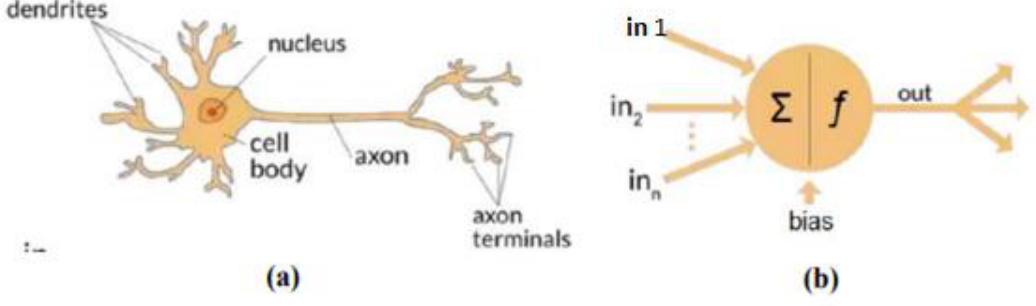
Figure 5. Examples of ( a ) biological and ( b ) artificial neurons.